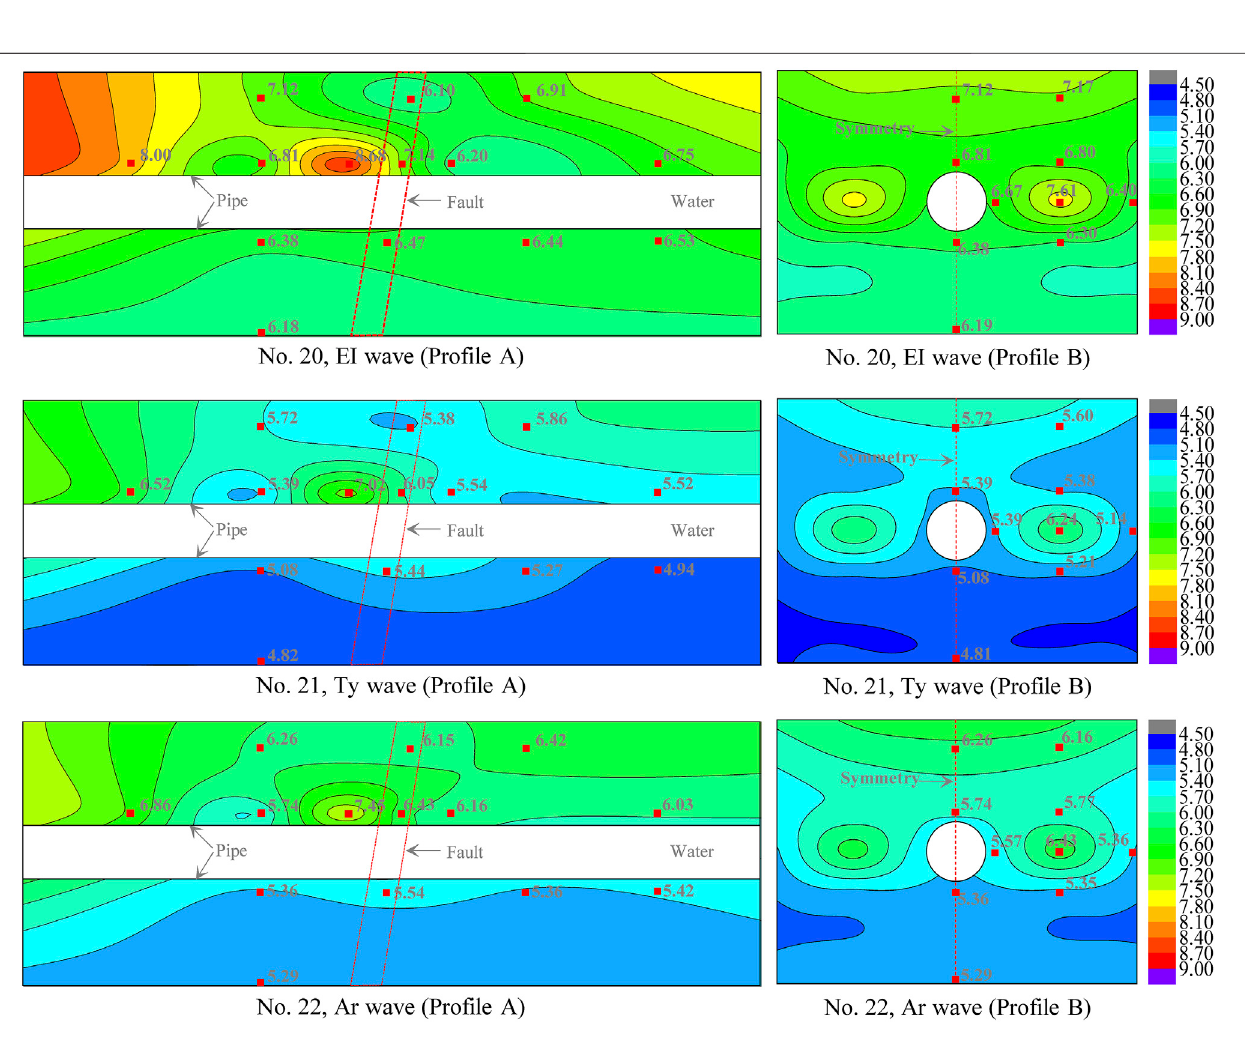
Frontiers in Earth Science |